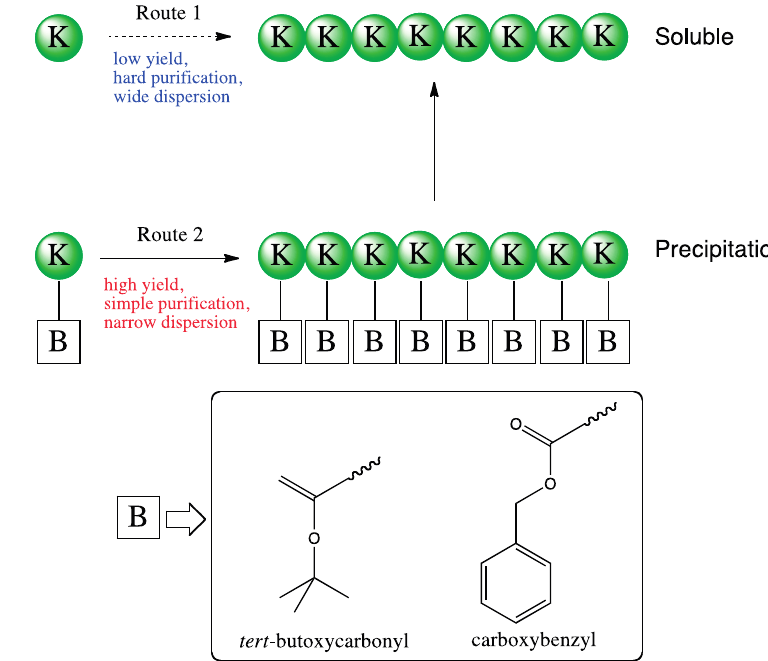
Figure 4. Papain-catalyzed synthesis of oligo( L -Lys) via direct oligomerization of L -lysine methyl ester (Route 1) or using the N -protected monomer L -lysine[B] methyl ester (Route 2). ε For the latter, B groups studied include tert -butoxycarbonyl and